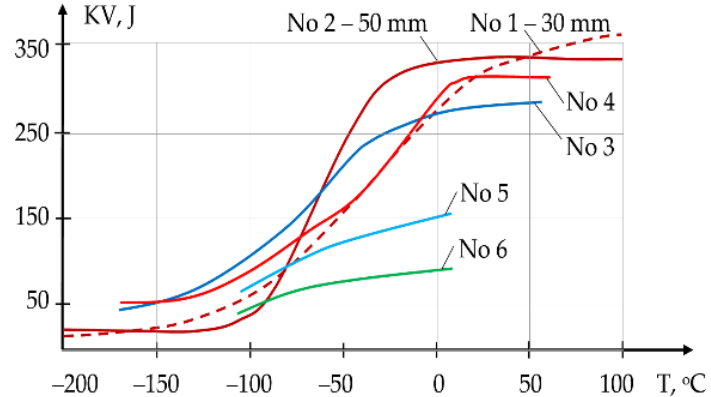
Figure 6. Impact energy at low temperatures: No. 1—SAF 2205 30 mm; No. 2—SAF 2205 50 mm. Data from [21]; No. 3—SAF 2205, No. 4—SAF 2507, No. 5—TIG-welding of SAF 2507. Data from Sandvik Materials Technology; No. 6—EB-welding of SAF 2205. Data from [22].